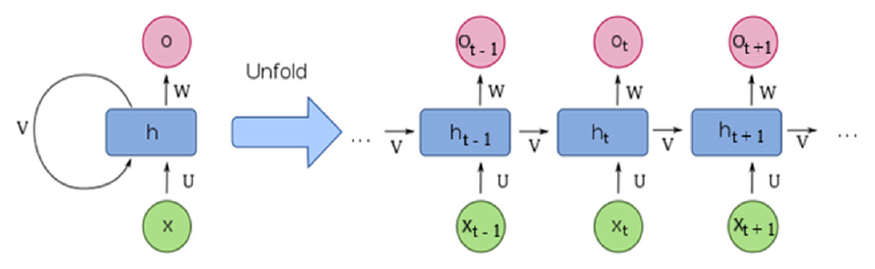
Figure 2. Sample structure of a recurrent neural network.